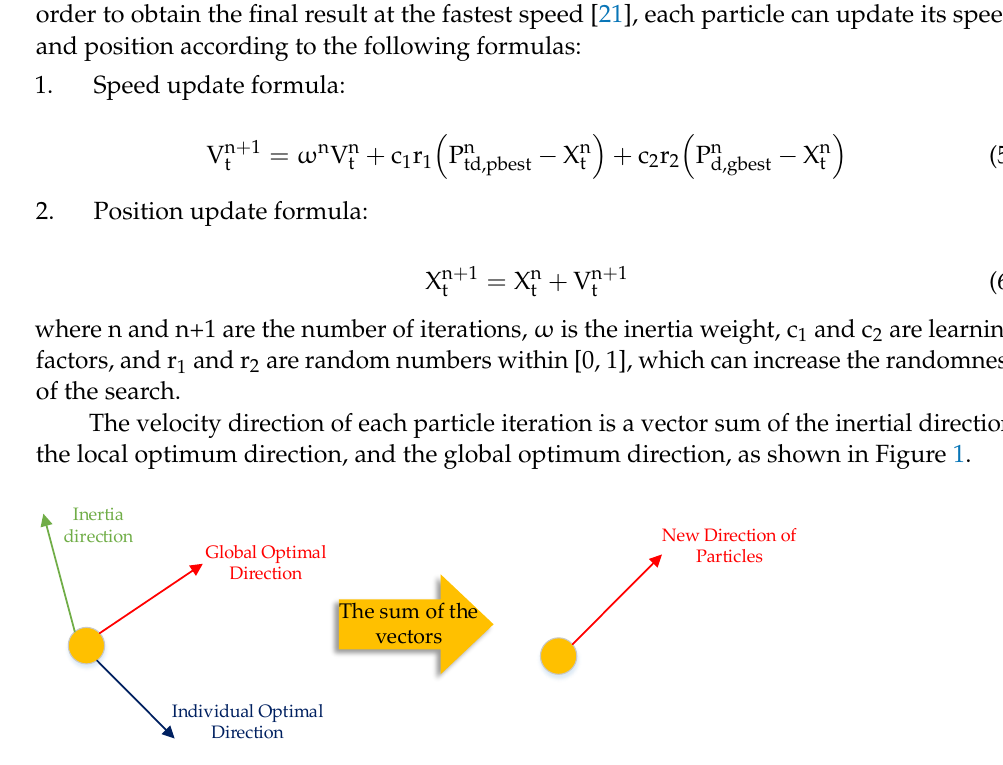
Figure 1. Schematic diagram of speed direction update.